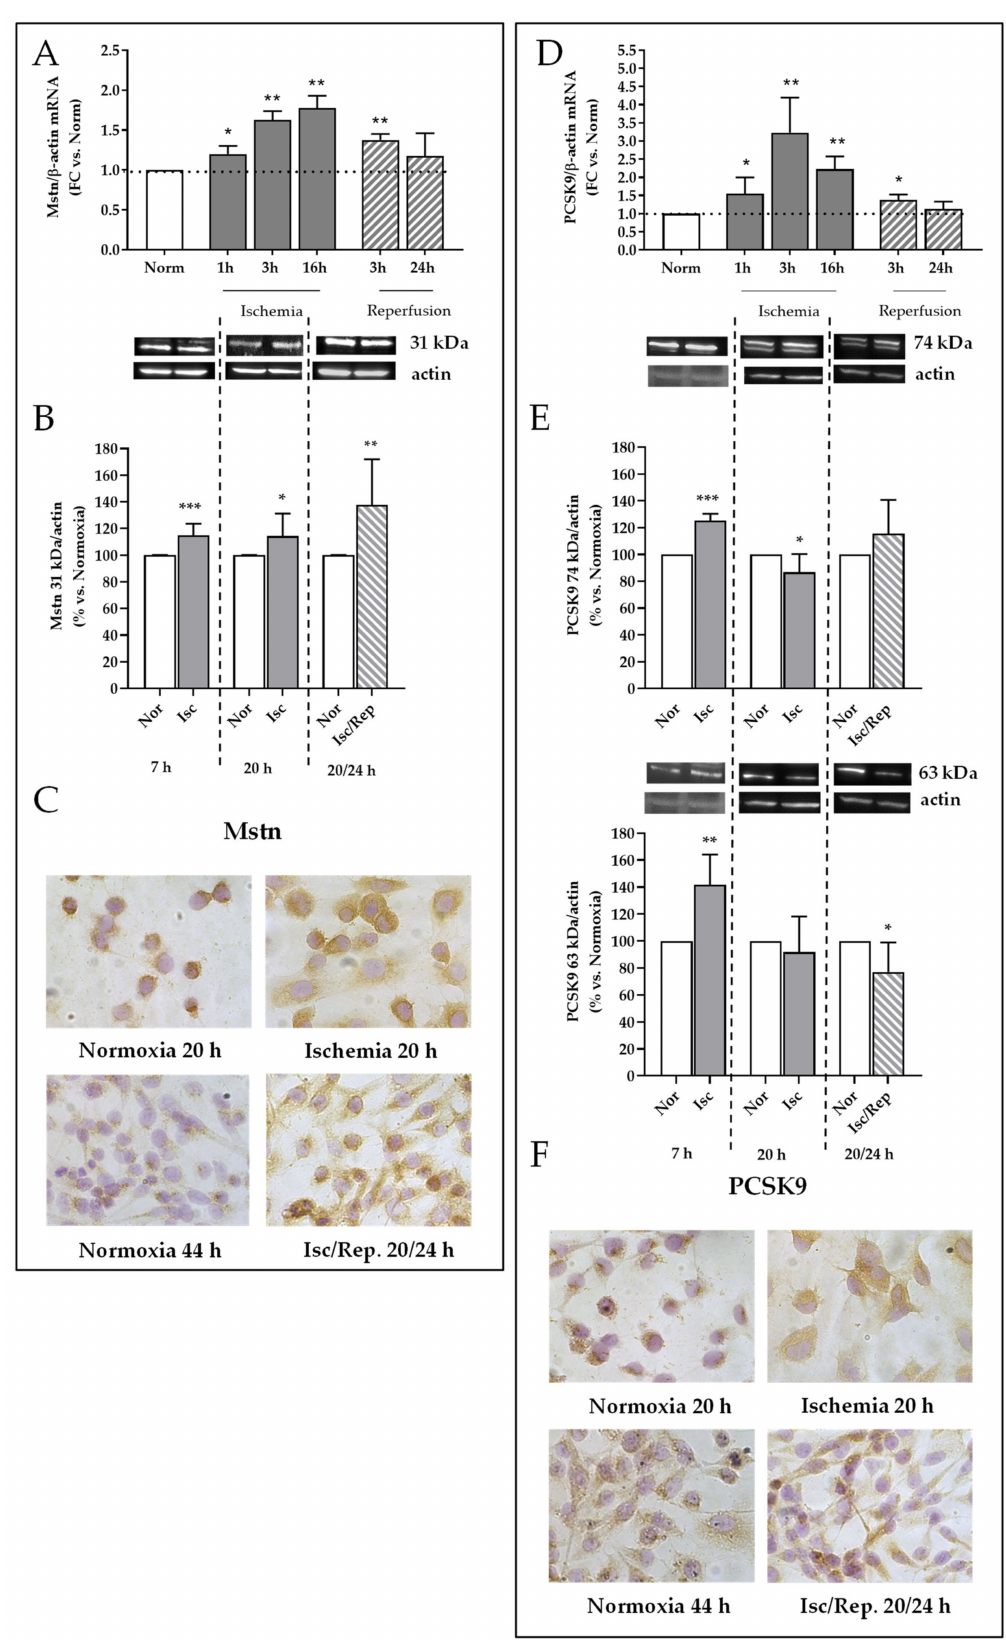
Figure 6. Mstn and PCSK9 during I/R in HK-2 tubular renal cells. Mstn: ( A ) mRNA levels after ischemia (1, 3, and 16 h) and reperfusion (3 and 24 h) by quantitative real-time PCR. The results have been normalized by expressing the number